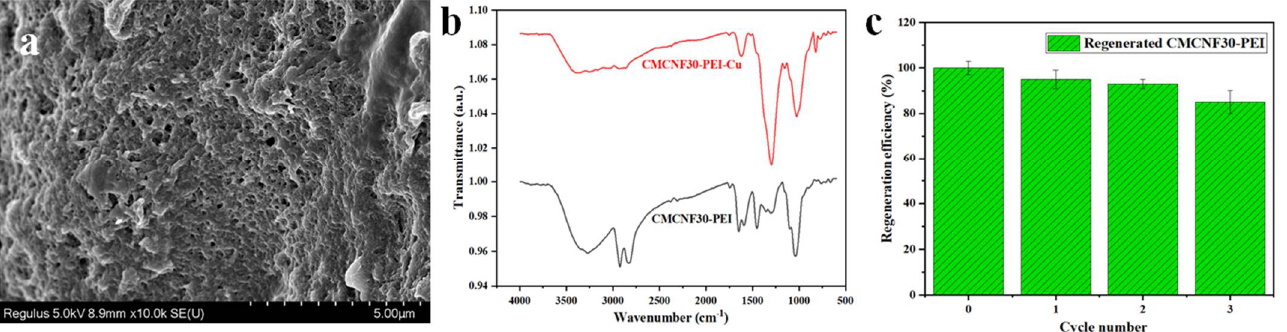
Figure 8. ( a ) SEM image of CMCNF30-PEI after adsorbed Cu 2+ . ( b ) FTIR spectra of CMCNF30-PEI aerogel and CMCNF30-PEI aerogel loaded with Cu 2+ . ( c ) Three adsorption cycles of CMCNF30-PEI aerogel for Cu 2+ solution.